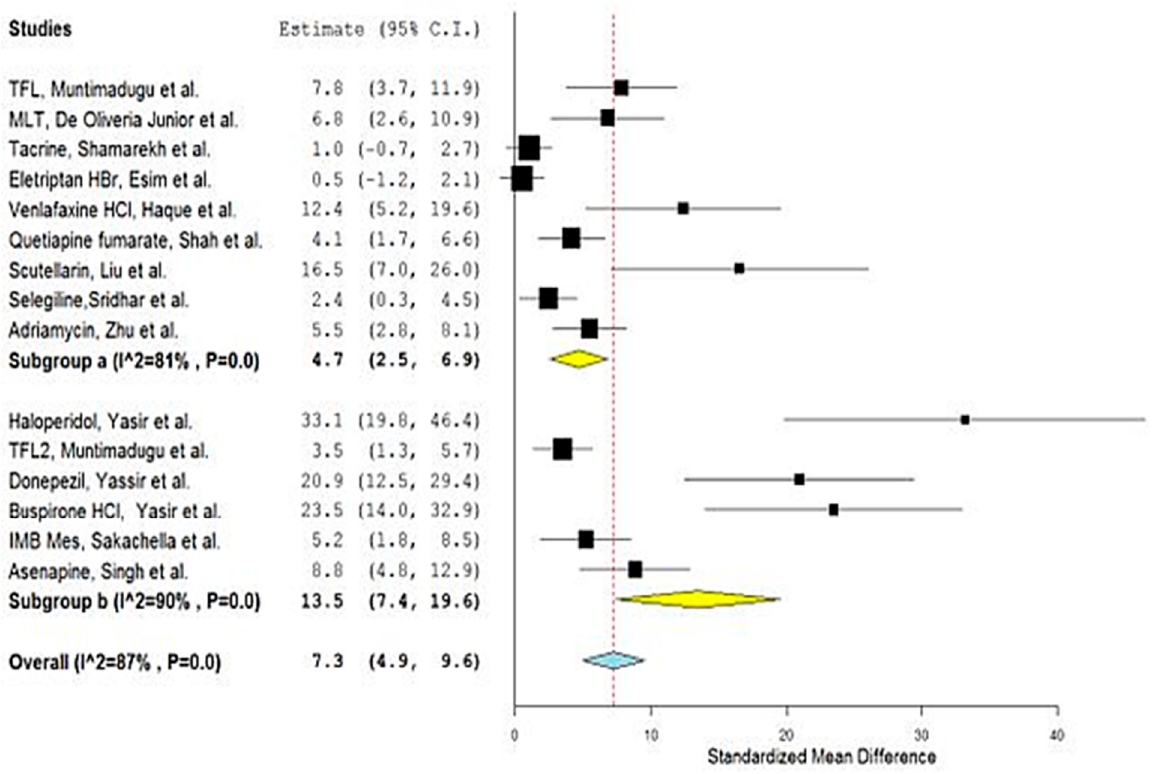
Figure 6. Forest plot of investigated subgroups: (a) polymeric nanoparticulate systems versus (b) lipid nanoparticulate systems for the studies: [1–3,5–8,11–17,19], (OpenMetaAnalyst results).